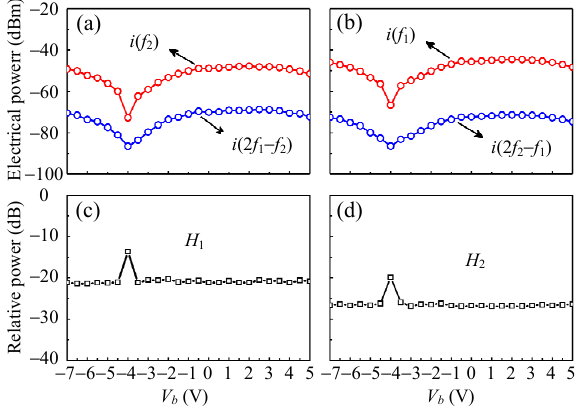
Fig. 3 Measured electrical power at different bias voltages: electrical power at (a) f 2 , 2 f 1 – f 2 and (b) f 1 , 2 f 2 – f 1 , corresponding relative power (c) H 1 and (d) H 2 in the case of f 1 = 10 kHz and f 2 = 10.01